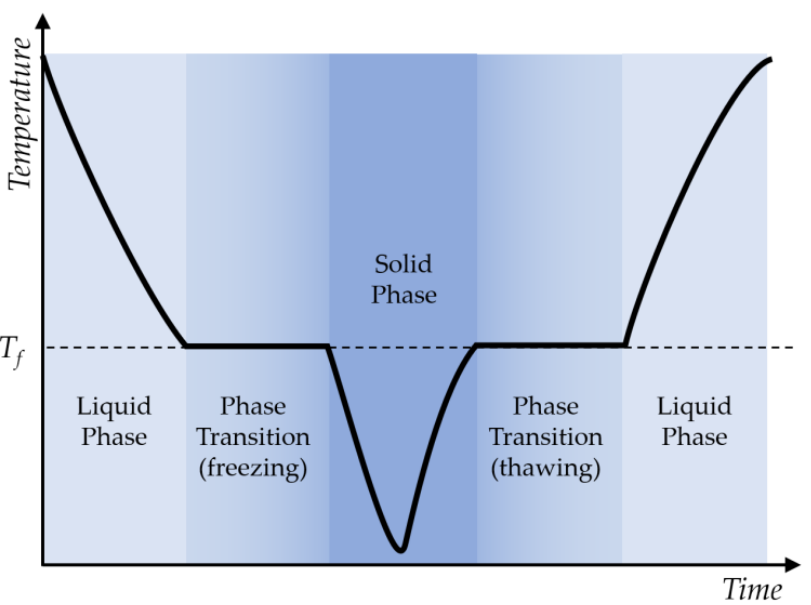
Figure 4. Temperature evolution of a liquid – solid PCM during a freezing – thawing cycle. The heat released or absorbed by the PCM does not translate into temperature changes during the phase transitions, contrary to when the PCM is fully liquid or solid. Hence, the expression “latent heat” (versus “sensible heat”). This occurs because any heat released or absorbed by the PCM is “used” to form or break intermolecular bonds, respectively, rather than translating into molecular kinetic energy (i.e., temperature). The latent heat exchanged during phase transitions is given by